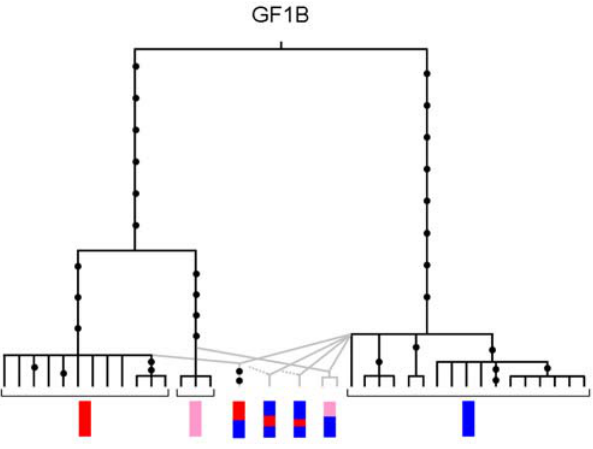
Figure 10. Ancestral recombination graph of the GF1B locus and schematic map of recombinant alleles. Mutations are indicated with dots. Dashed lines indicate that the parental allele of the recombinant could not be precisely identified.